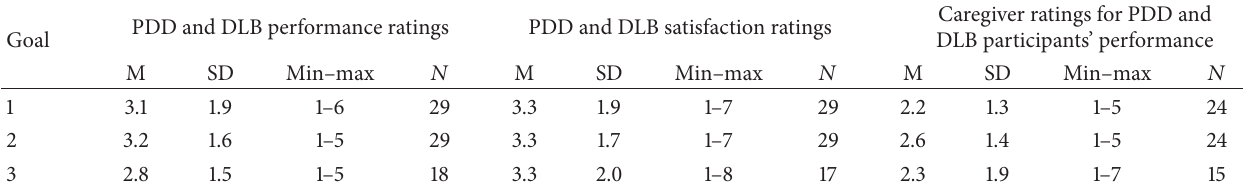
Table 2: Mean ratings for PDD and DLB participants’ goal performance and satisfaction.